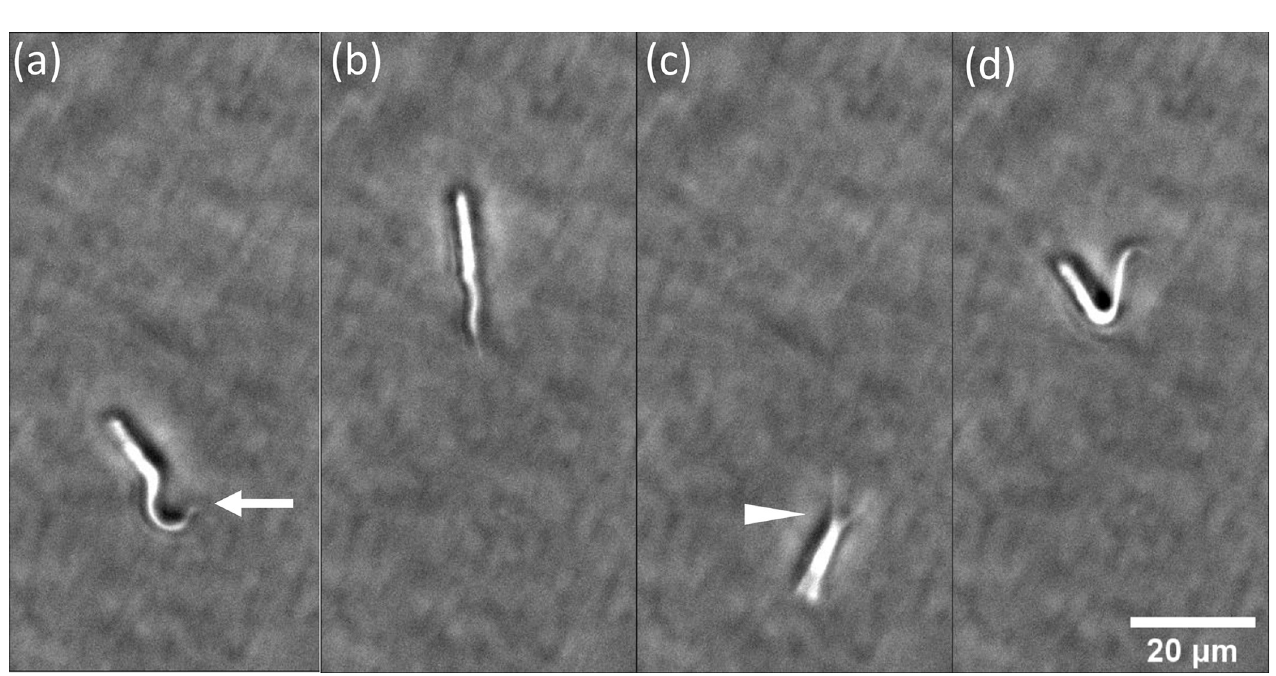
Fig 7. Relocation of the parasite-end of a filament during a shear stress cycle with pauses at a) and c). (a) initial adhesion of the parasite to the surface by the anterior part of the flagellum (white arrow) under no flow, (b) after exposure to a shear stress of 0.93 pN/ μ m 2 , (c) during the subsequent pause and under 1.24 pN/ μ m 2 . Flagellar beating during the pause resulted in the rotation of the parasite around a pivot point marked by the white arrowhead and near the flagellar pocket. At 1.24 pN/ μ m 2 , the parasite acquires a “V” shape shown in (d), indicative of the change in the position of the parasite-end of the nanotubule.